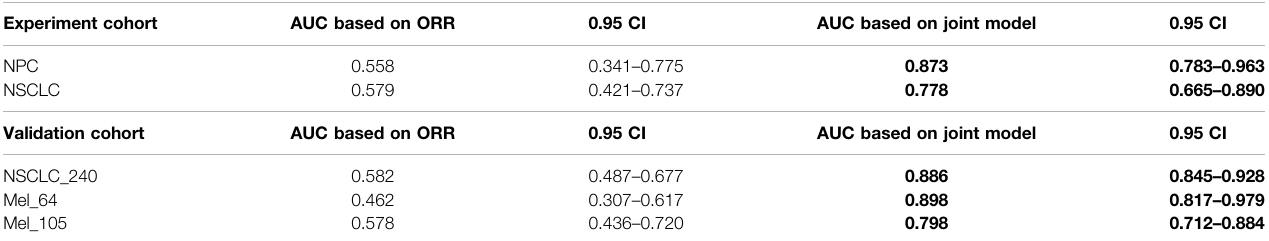
TABLE 5 | AUC comparison. The table reports the area under the curve (AUC), as well as the corresponding 0.95 con fi dence interval, for each metric (columns) applied to a different cancer cohort (rows). Bold-faced values indicate the best value for each cancer cohort.